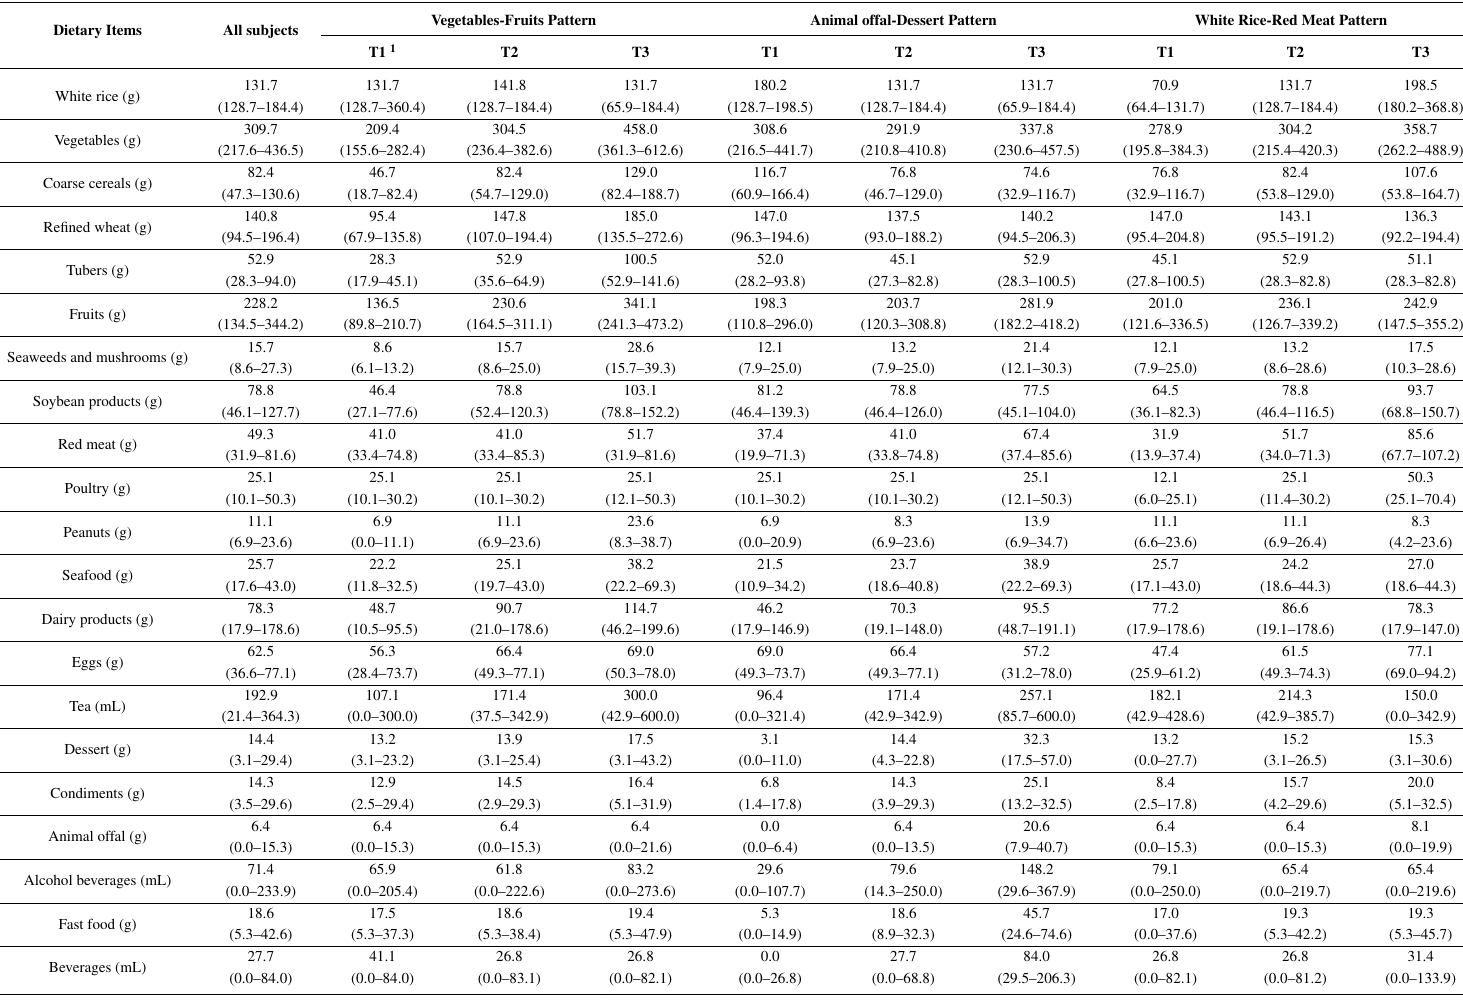
Table A1. Intakes of selected dietary items according to tertiles of dietary pattern score among Chinese